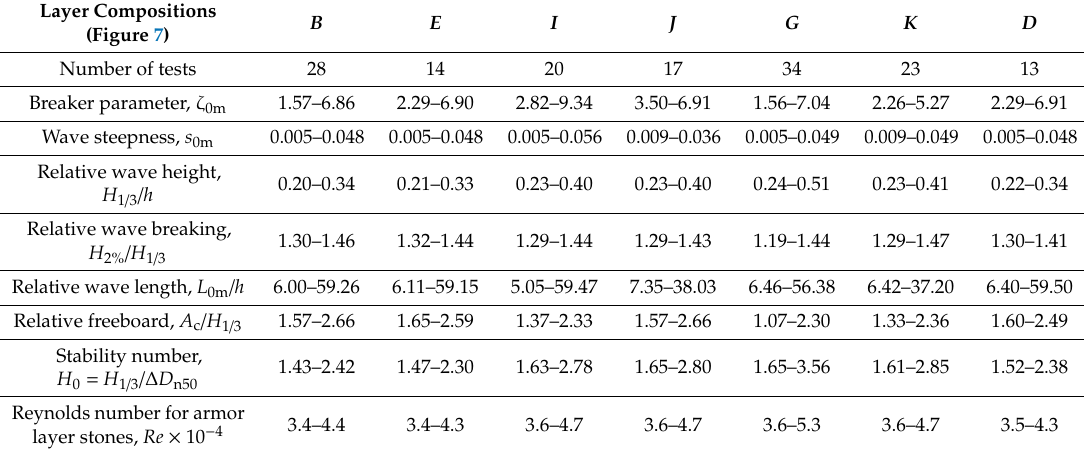
Table 3. Main characteristics of